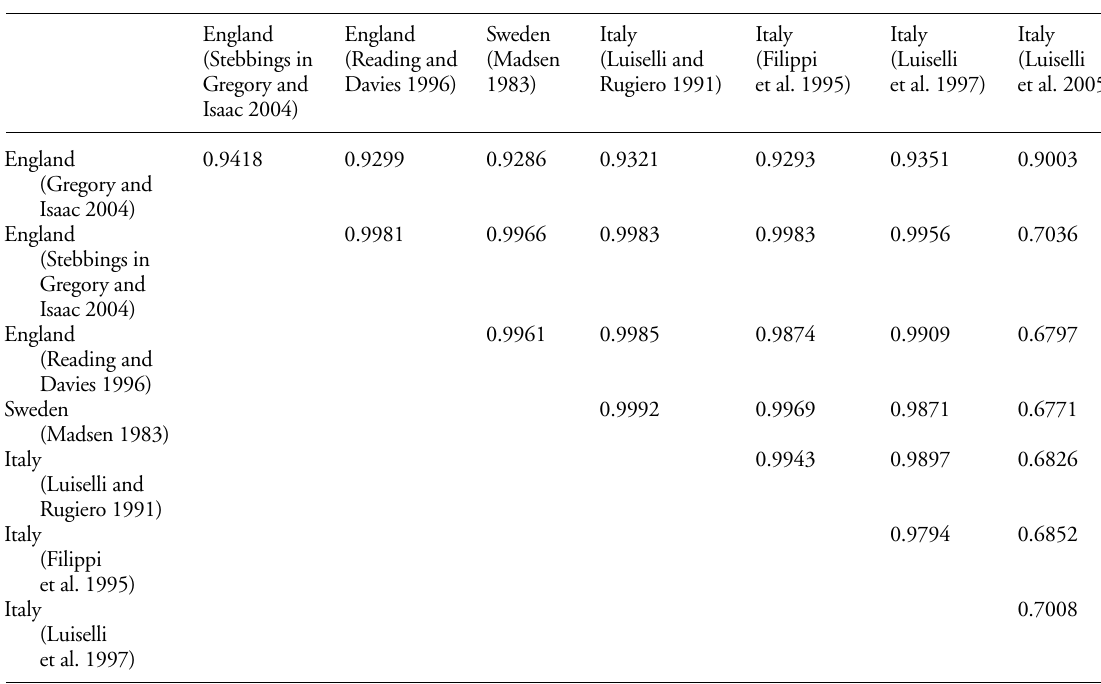
Table 1. Example of a data matrix used for this study; the species used for this example is Natrix natrix . Each cell in this matrix represents the value of Pianka’s (1986) similarity index between two populations of the study species; also the study areas and the original literature sources are given. Note that this dataset is relative to diet similarity expressed as “general affinity” (see the text for more